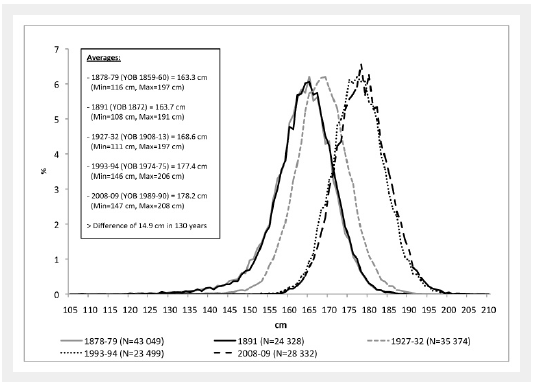
Evolution of the average height (cm) of 19-year-old Swiss conscripts from 1878–79 to 2009 (1992–2009: individual data, before 1992: published